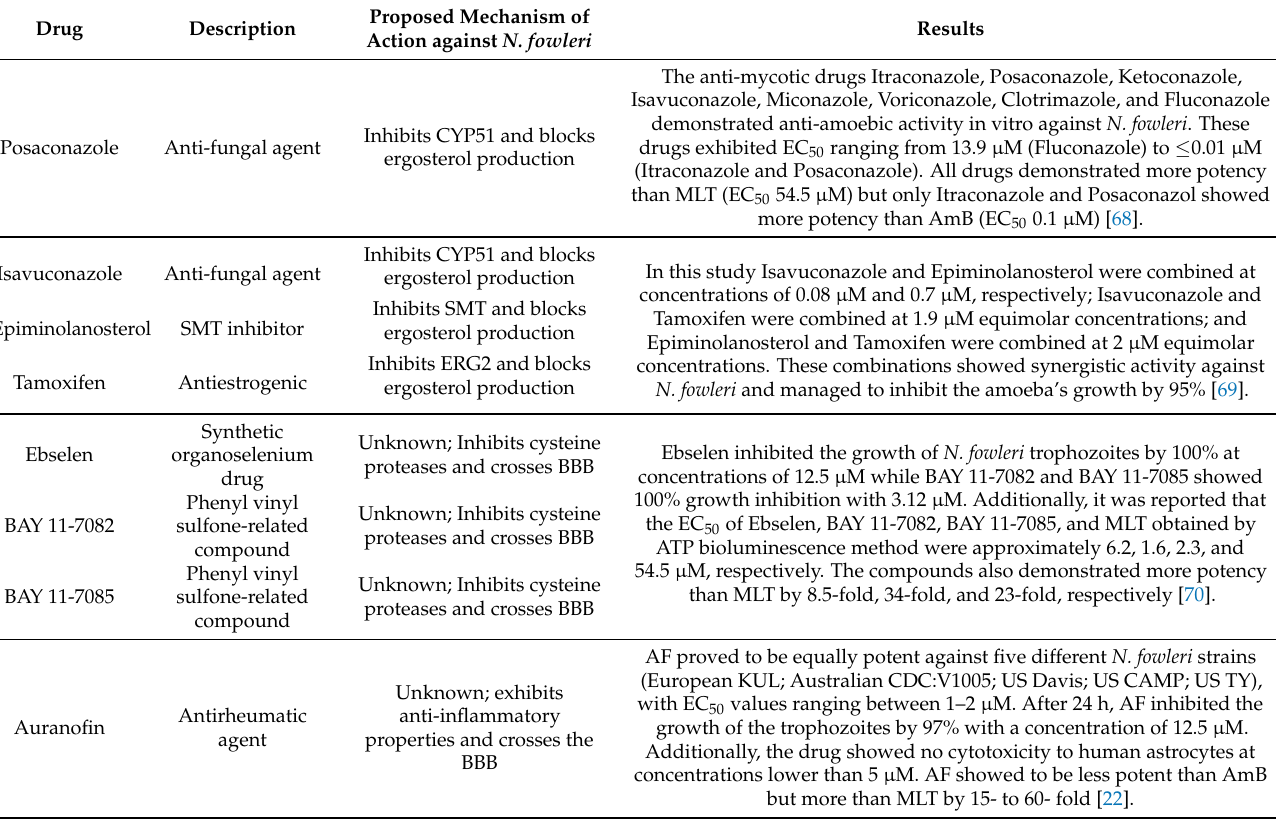
Table 1. Drugs being studied in vitro to determine their amoebicidal activity against N. fowleri